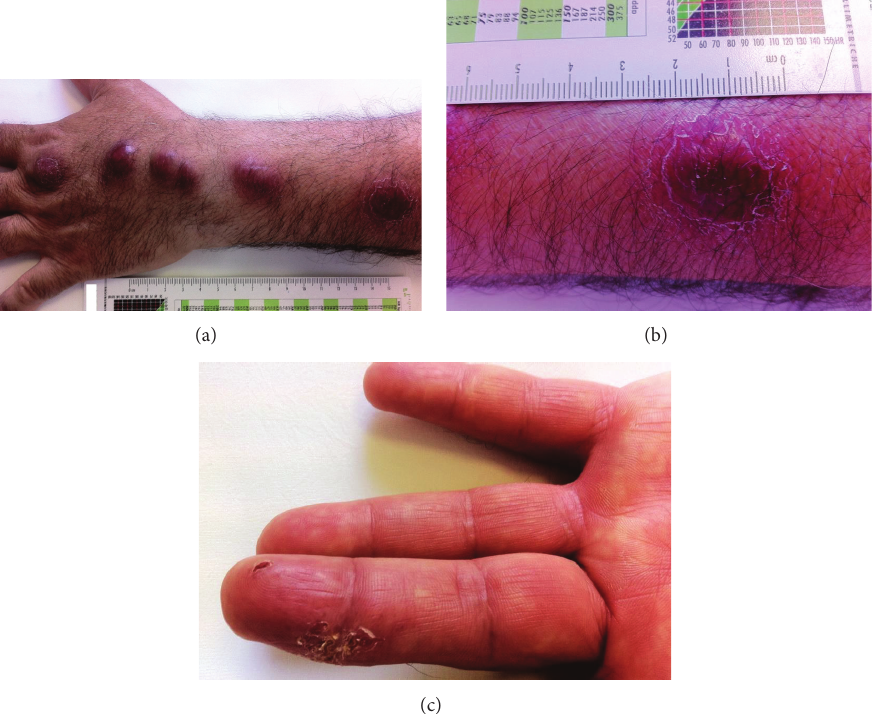
Figure 1: Multiple nodular lesions arranged in a linear fashion along the left hand and forearm of the patient (a). Detail of the nodules (b). Probable site of fungus inoculation, represented by a small ulcer on the fingertip of the third digit